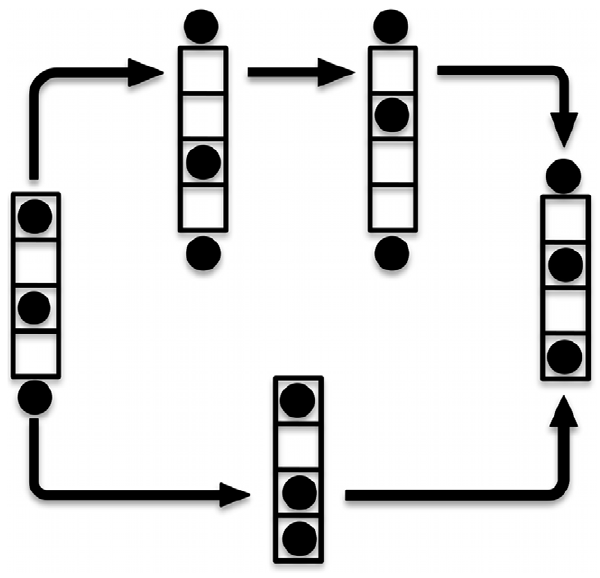
Figure 2. Schematic models of ion permeation. The ion permeation along a schematic selectivity filter displaying four coordination sites is shown. The cycle involves two opposite configurations of a doubly occupied filter (on the left and on the right), while a third ion is transferred from the intra- to the extra-cellular side. Only the rate limiting step of the whole permeation cycle is shown. The ion translocation can be achieved via both a knock-on (lower pathway) and a vacancy diffusion mechanism (upper pathway).